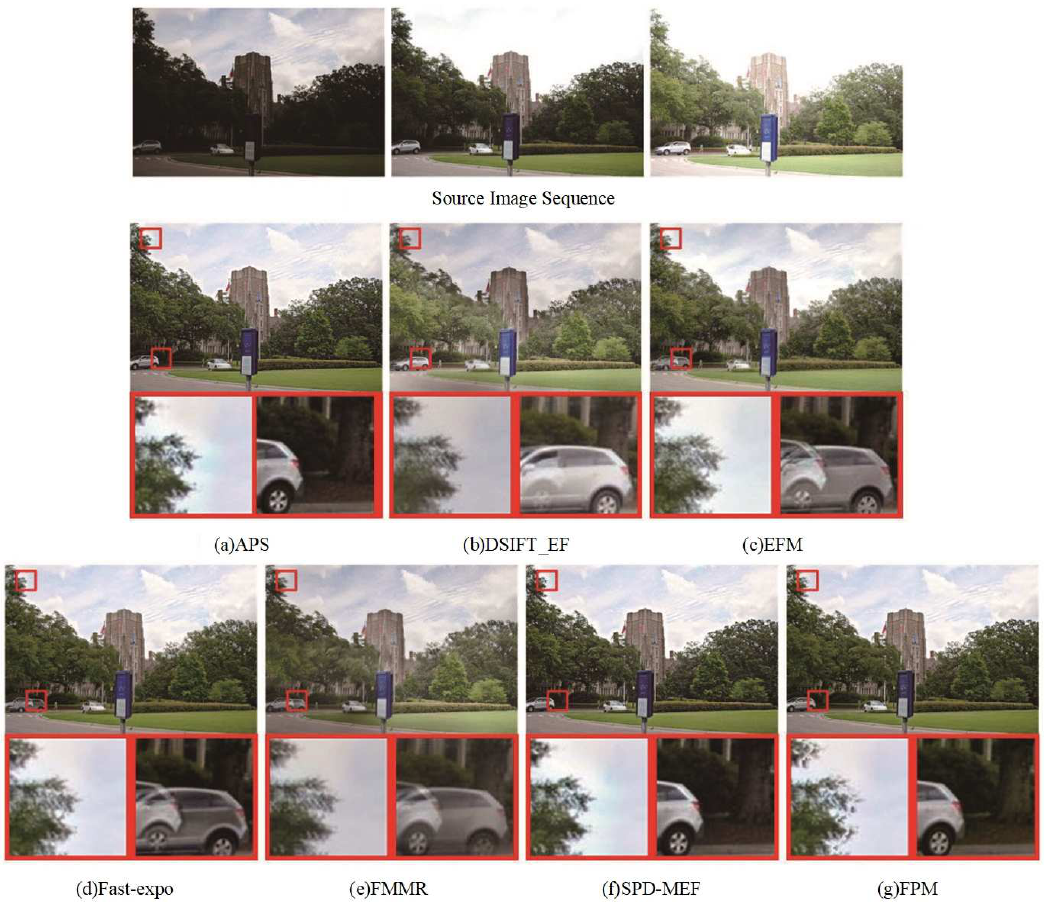
Figure 6. Comparison of the “Duke” fusion images obtained by the seven fusion methods. ( a )